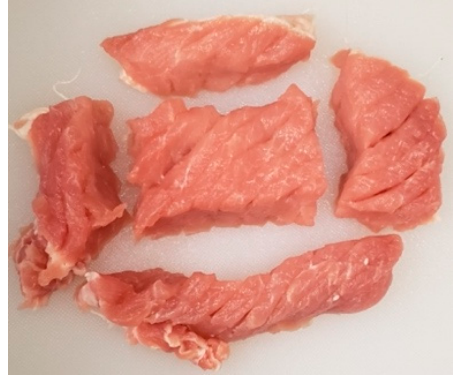
Figure 2. Meat internal core prior to the flaming